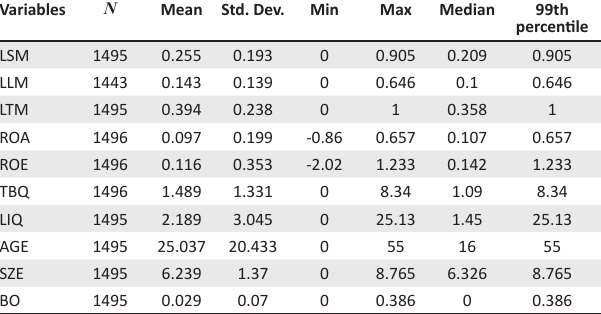
TABLE 2: Descriptive statistics of the variables used to determine the effect of direct black ownership on capital structure and performance. Variables N Mean Std. Dev.